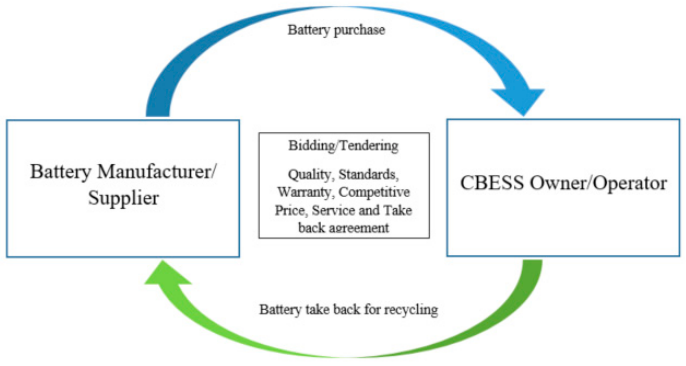
Figure 19. E-rickshaw battery value chain for BSCS option.